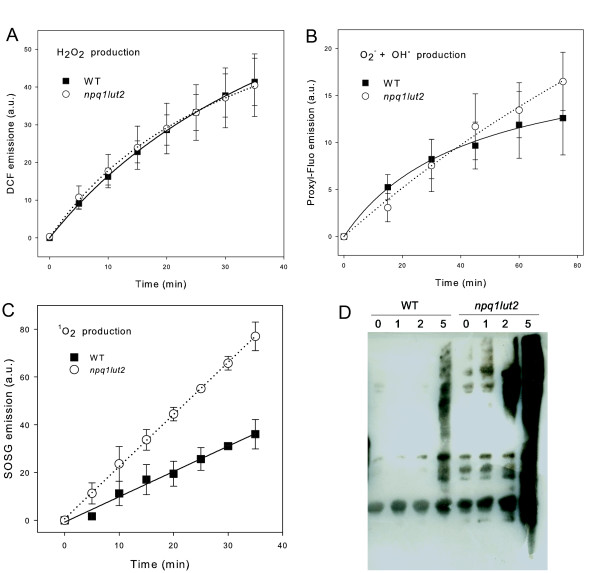
Steady-state accumulation of ROS species and protein oxidizing activity in wild type and npq1lut2 mutant plants. Specific probes were used to quantify the accumulation of several ROS in wild type and npq1lut2 detached leaves under stress (1000 μmol photons m-2 s-1, 10°C). (A) DFC and (B) ProxF fluorescence was used to follow the accumulation of reduced forms of ROS. (C) SOSG fluorescence was used to follow singlet oxygen (1O2). Details on ROS measurements are given in material and method session. Symbols and error bars show means ± SD. (D) Western-blots were used to detect oxidized thylakoid proteins extracted from wild type and npq1lut2 membranes. WT and npq1lut2 rosettes were pre-treated for 48 h at 10°C and low light as described in methods, then were exposed to photoxidative conditions (1000 μmol photon m-2 s-1, 10°C, 16 h light/8 h dark). Leaves were harvested and thylakoids isolated before stress (0) and at same time after 1, 2 and 5 days of HL.